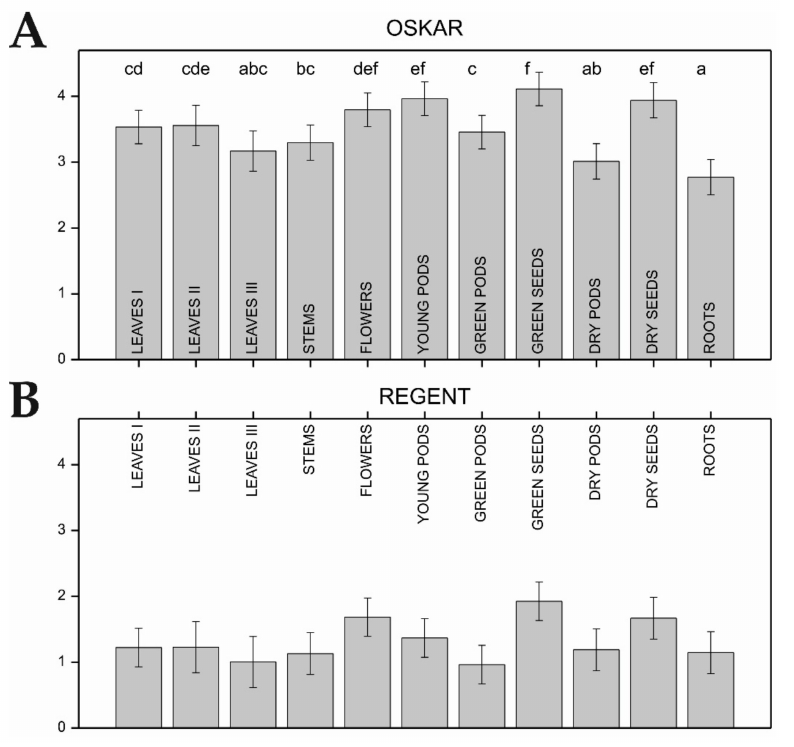
Figure 3. Total alkaloid content (TAC) in particular organs of narrow-leafed lupin measured by gas chromatography (GC) assay—( A ) bitter cultivar Oskar; and ( B ) sweet cultivar Regent. Mean values and standard errors are depicted. In the bitter cultivar, groups of similar organs, found using Fisher’s protected LSD test ( p < 0.05) are indicated by the same lowercase letter. No significant differences in QA content across organs were found for the sweet cultivar. TAC values are shown as log 10 -transformed